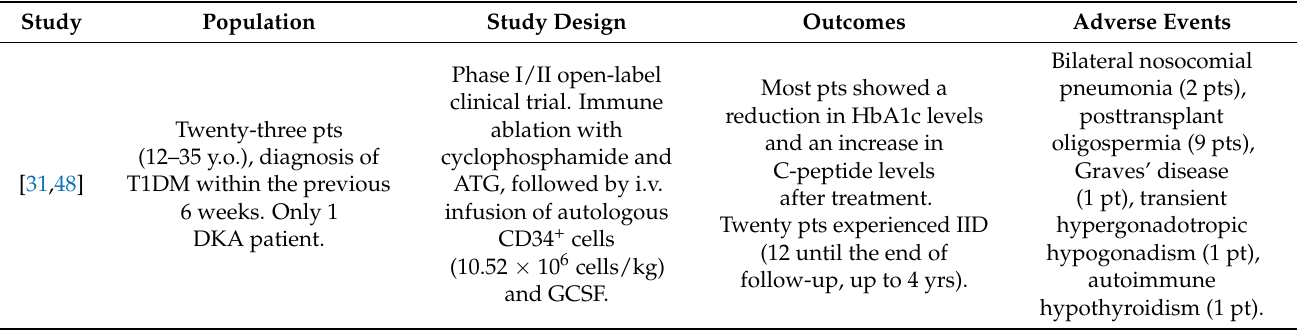
Table 1. Clinical trials testing AHST in the treatment of